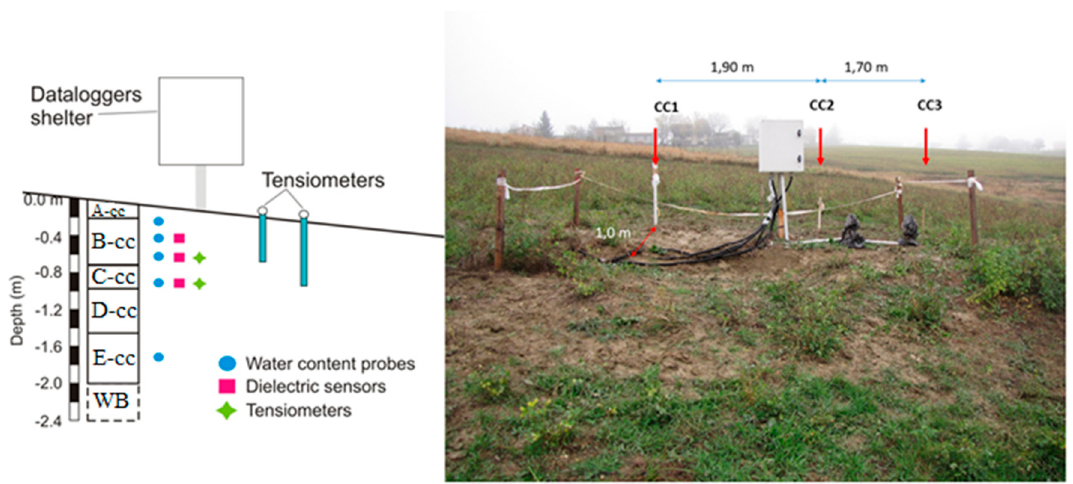
Figure 5. Soil profile and sketch of the Costa Cavalieri (CC) monitoring station.